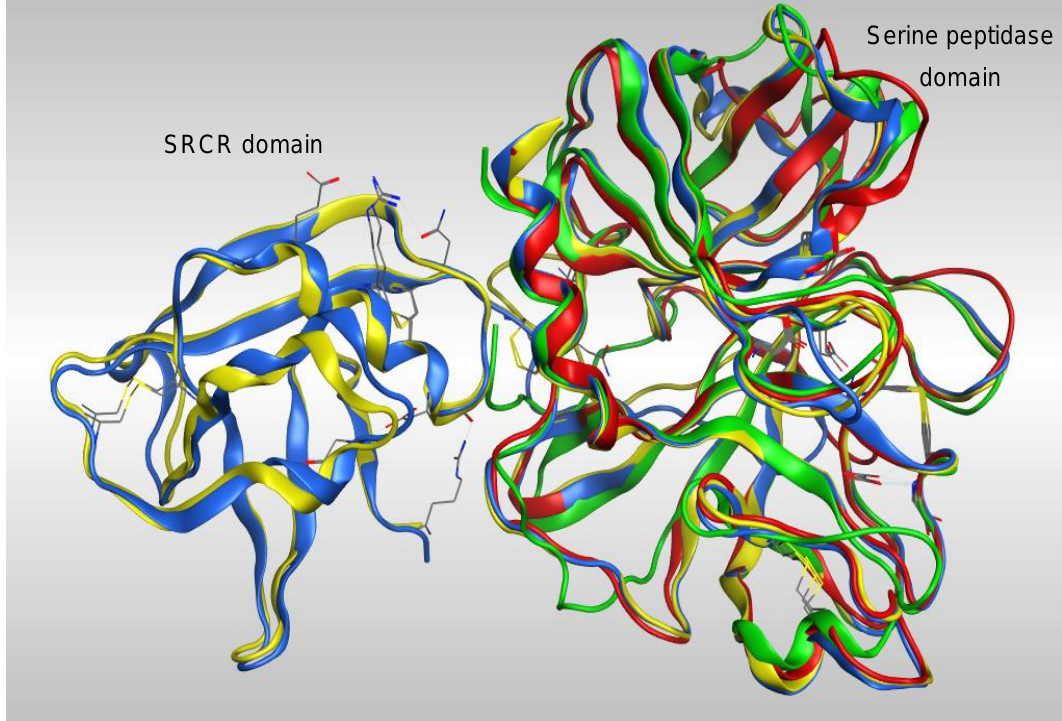
Figure 3. Overlap of the four TMPS2 models generated from crystal structures 5CE1_A (blue), Please ensure that intended meaning has been retained. 1Z8G_A (yellow), 6KD5_B (red) and 6O1G_A (green).